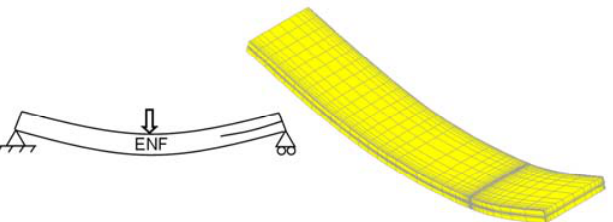
Fig. 6. The ENF test case, and its finite element